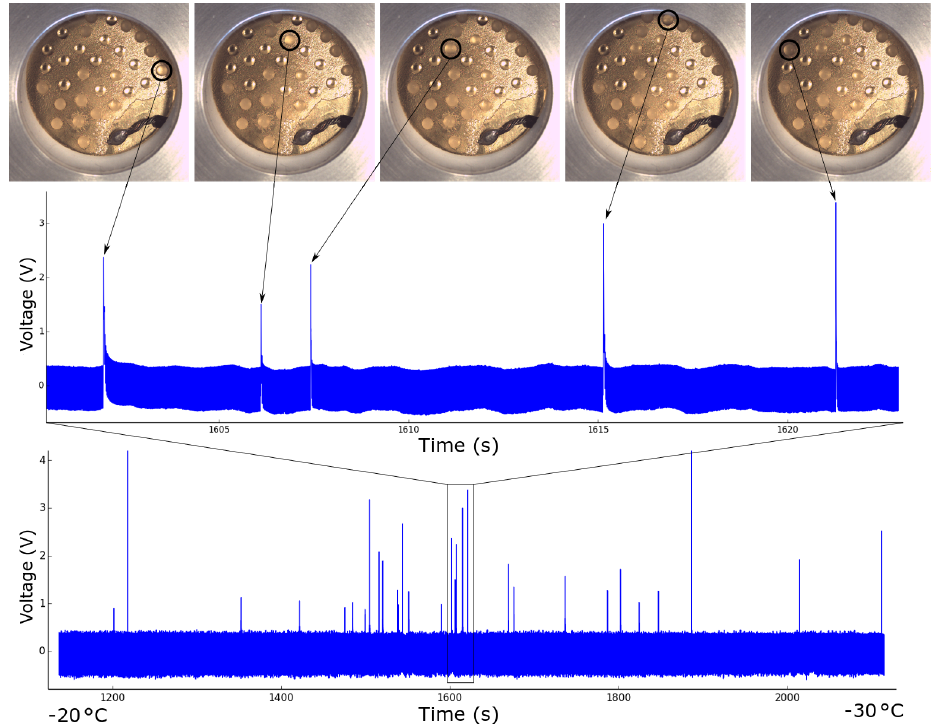
Figure 4. Raw data from a typical experimental run, in this case pure water droplets measured to determine the background freezing rate of the instrument. Each spike represents a droplet freezing, as shown in the upper graph and corresponding pictures. Approximate temperatures corresponding to the start and end of the run are shown at the